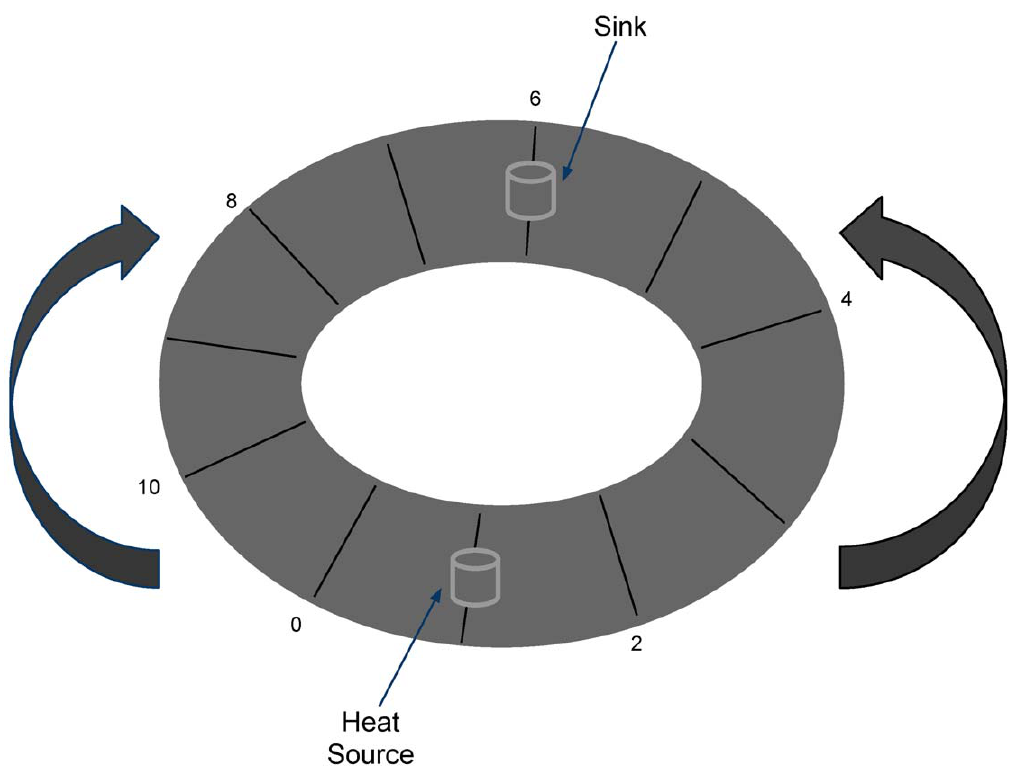
Figure 3. Figure showing the simulation set-up. Heat flows in the direction from the Source to the Sink .